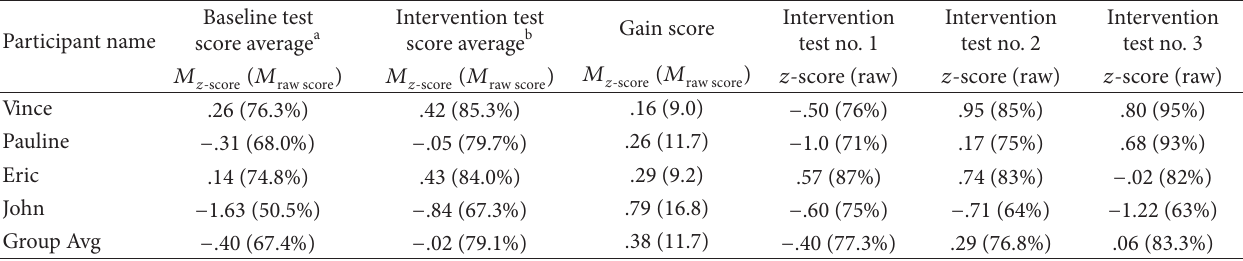
T 2: Biology test performance of participants before and during SREP